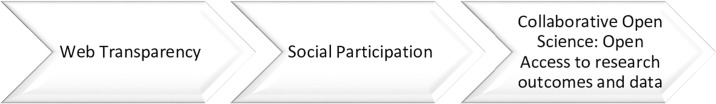
Open Government framework in high education and research institutions.